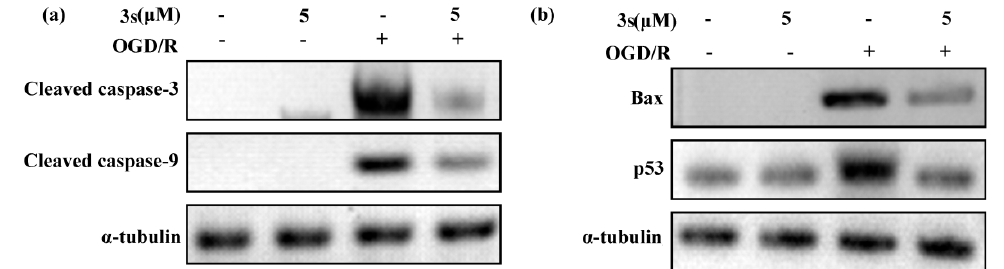
Figure 5. The mechanism of 3s reverses OGD / R responses. ( a ) 3s downregulated the expression of cleaved caspase-3, cleaved caspase-9 in cells treated with OGD / R; ( b ) 3s downregulated the expression of Bax, and p53 proteins in cells treated with OGD / R. Changes in the levels of proteins were analysed by a Western blotting with antibodies.